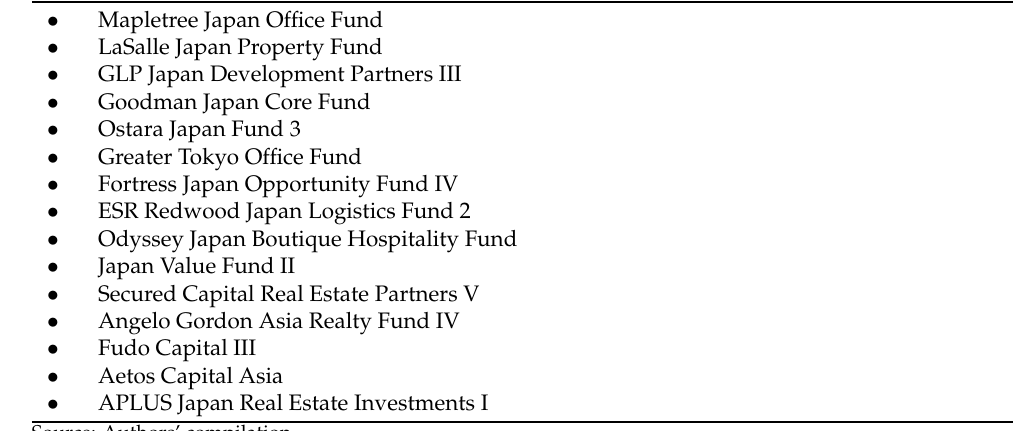
Table 3. Japan non-listed real estate funds: